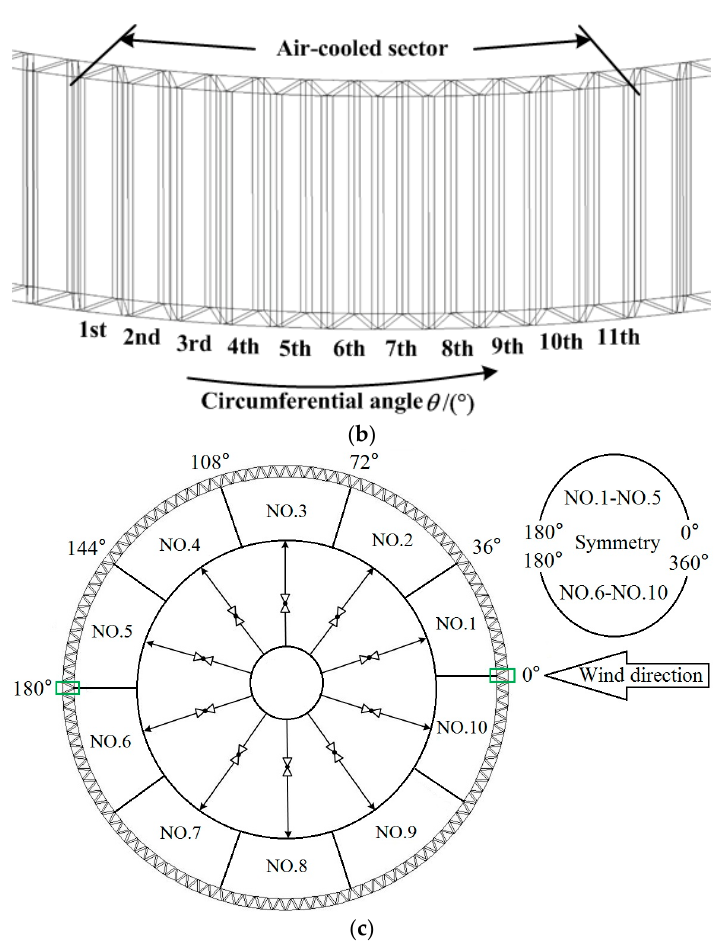
Figure 1. Geometric schematics. ( a ) Natural draft dry cooling system (NDDCS); ( b ) 11 deltas in each sector; ( c ) sectors and wind direction.